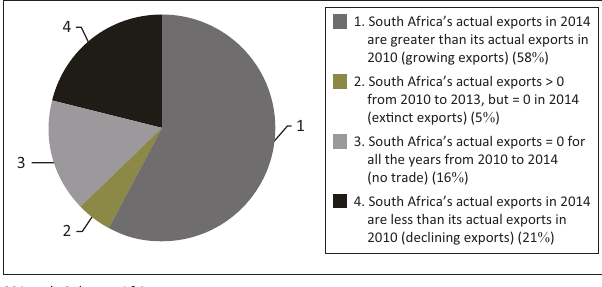
FIGURE 4: South Africa’s actual exports (from 2010 to 2014) to SSA countries at the Harmonised System six-digit level for the matched product-country combinations selected in Step 2. TABLE 3: Summary of the regional status of South Africa’s actual exports from 2010 to 2014 for the matched product-country combinations identified in SSA.